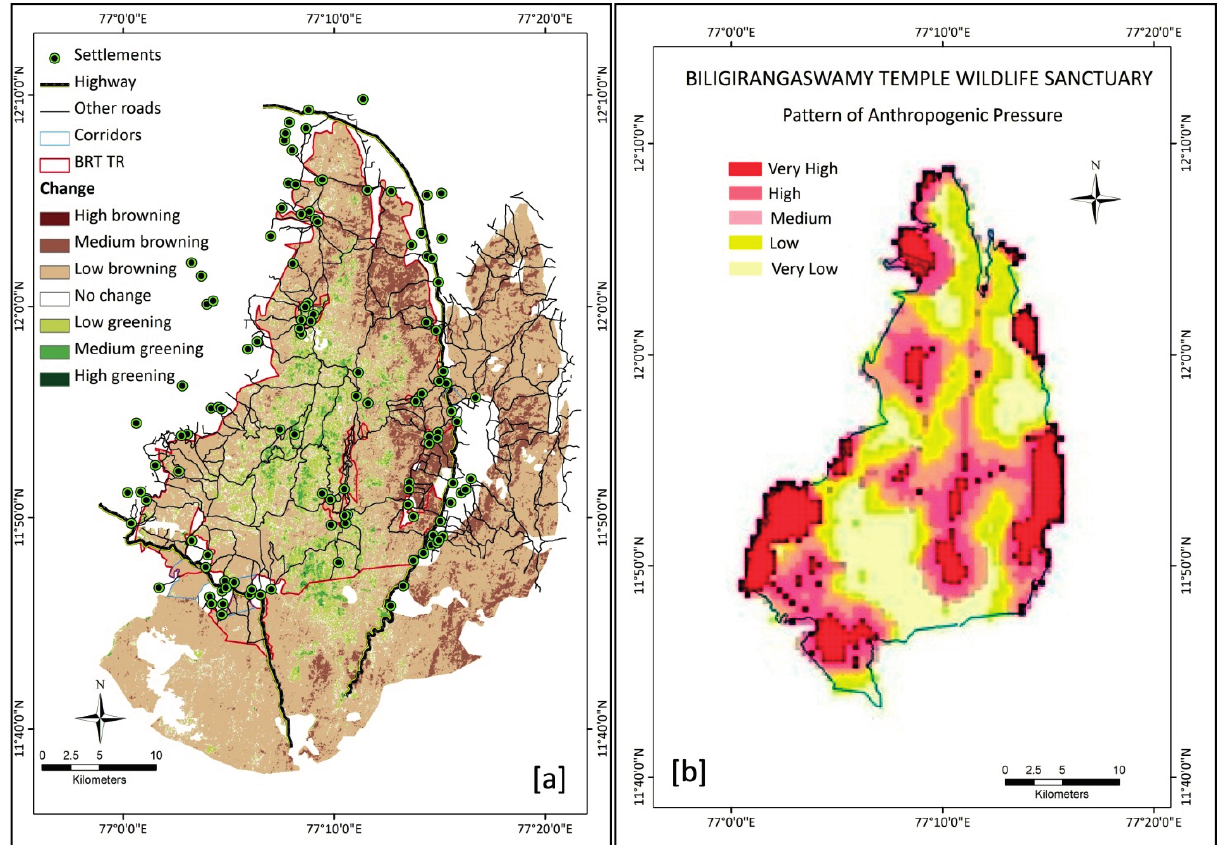
Figure 7. ( a ) NDVI change, settlements and road networks in Biligiri Rangaswamy Temple Tiger Reserve (BRT). ( b ) Composite Threat Index map of BRT. (Map (b) source: Barve et al. 2005. Reproduced with permission from authors).